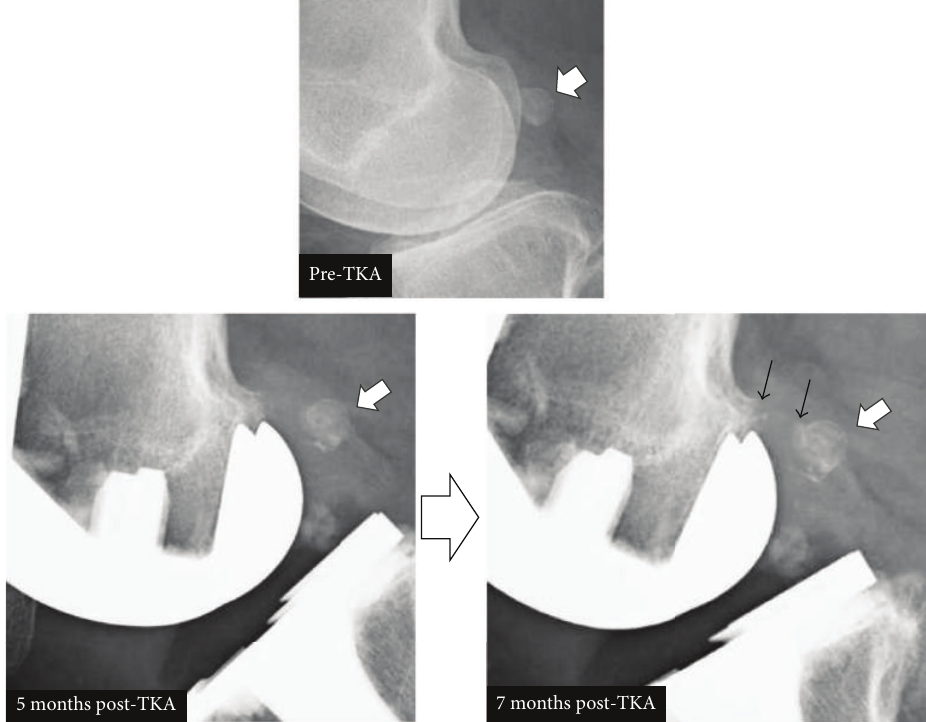
Figure 2: Plain, lateral view radiographs of the knee at several time points; the white arrow identifies the fabella and the black arrow onset and progression of osteoarthrosis.